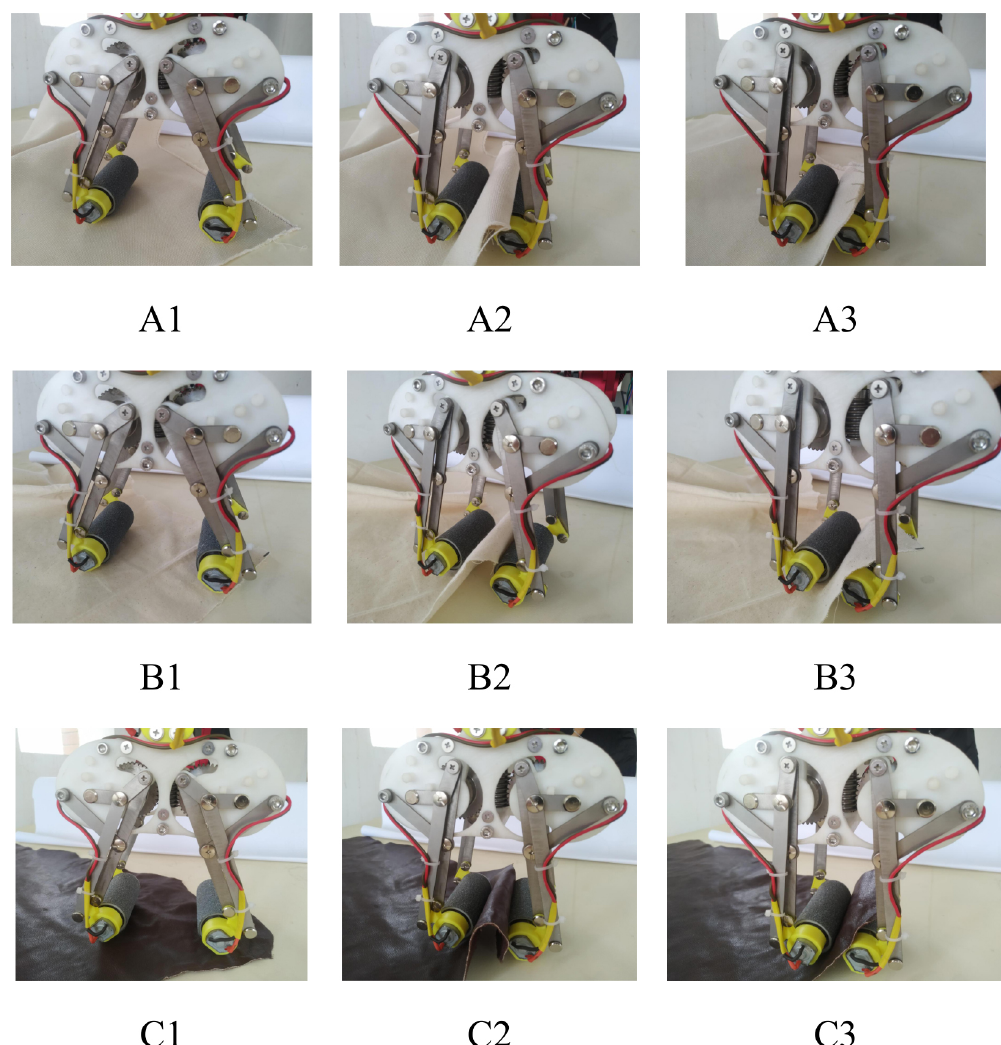
Figure 16. Experiment of fabric grabbing, stretching and spreading.